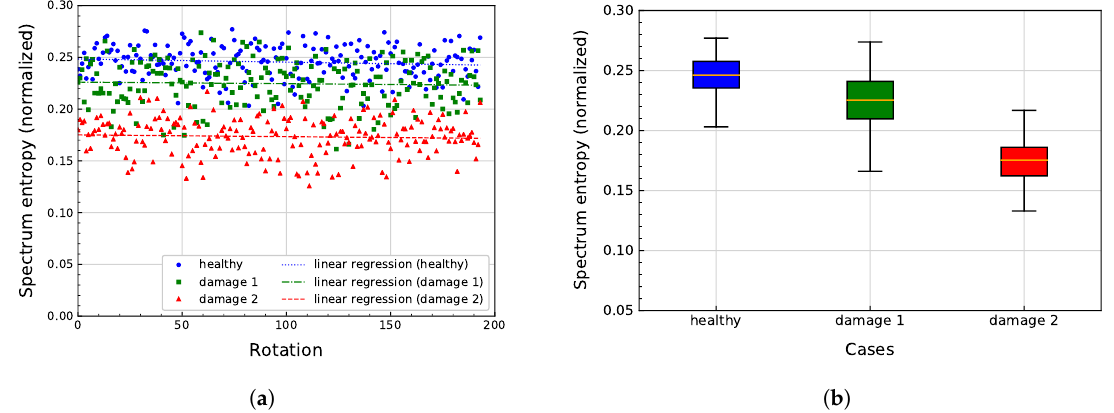
Figure 6. Results of the SE calculation for the PE signal from the raw vibration signal for all scenarios at 10 rpm. ( a ) Values for each rotation of the bearing. ( b ) Box plot for statistical analysis of the calculated values. Table 3. Linear regressions for all the scenarios at 10 rpm.